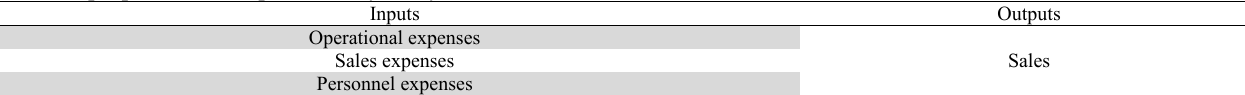
Elements proposed for the productivity analysis